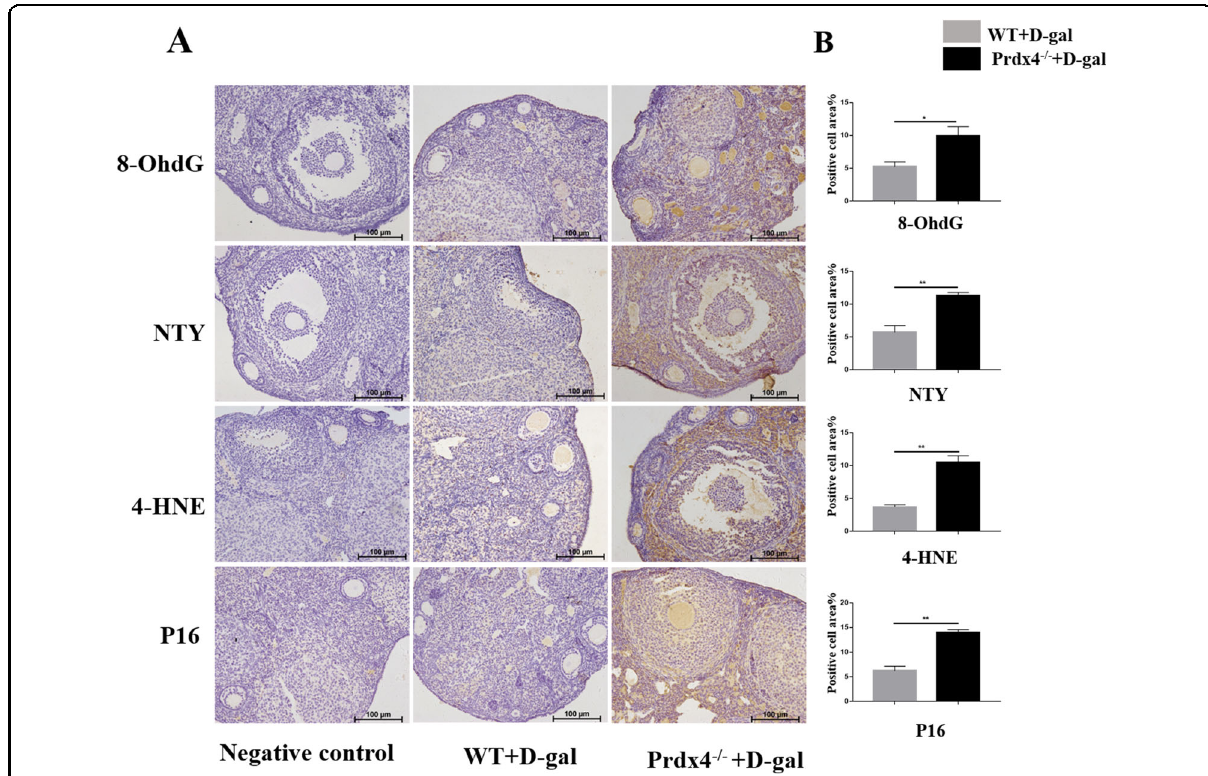
Fig. 4 Increased oxidative damage and ovarian senescence-associated protein expression in Prdx4 − / − mice. a The cellular localisation of oxidative damage-related factors (8-OHdG, NTY and 4-HNE) and an ovarian senescence-associated protein (P16) were observed using immunohistochemistry. The Prdx4 − / − group showed signi fi cantly increased expression of 8-OHdG, NTY and 4-HNE proteins in ovarian interstitial cells. The ovarian senescence-associated P16 protein was localised mainly in granulosa cells and oocytes, and their expression levels were relatively decreased in interstitial cells. Obviously increased P16 expression was detected in the Prdx4 − / − mouse group. Scale bars = 100 μ m at ×20 magni fi cation. b Protein expression was quantitatively analysed. All data are shown as means ± SEMs, n = 5. Statistical signi fi cance: * P < 0.05, ** P <